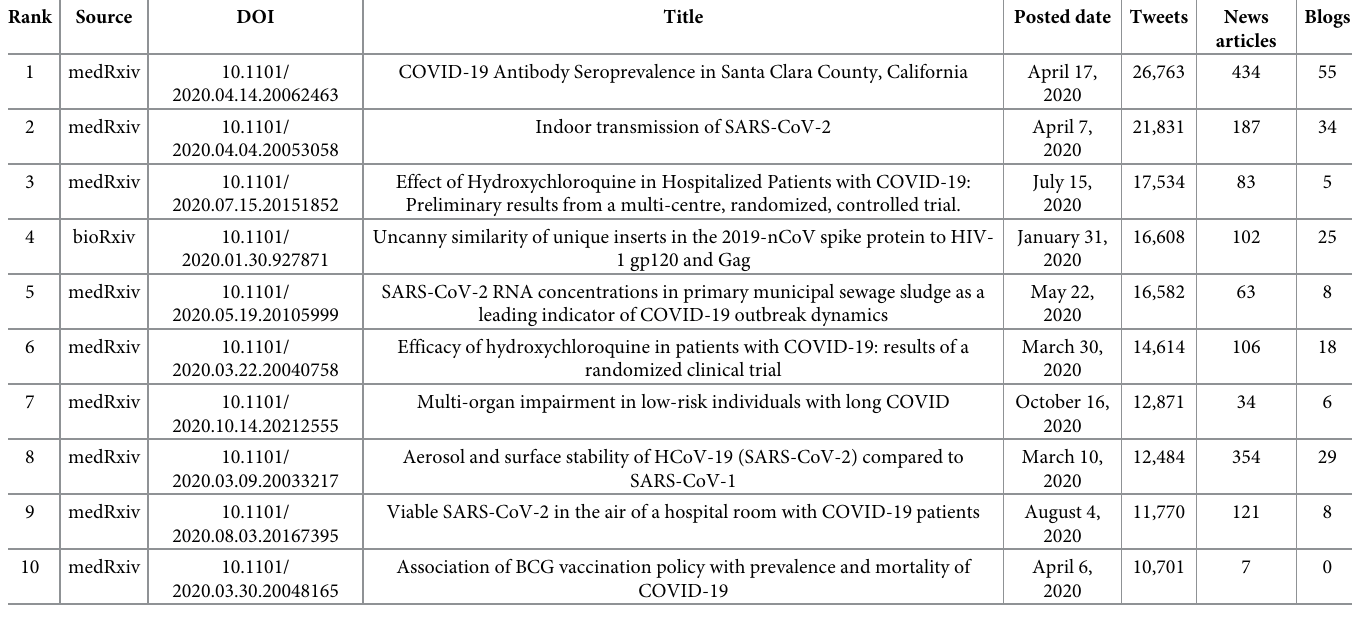
Table 2. Top 10 tweeted COVID-19